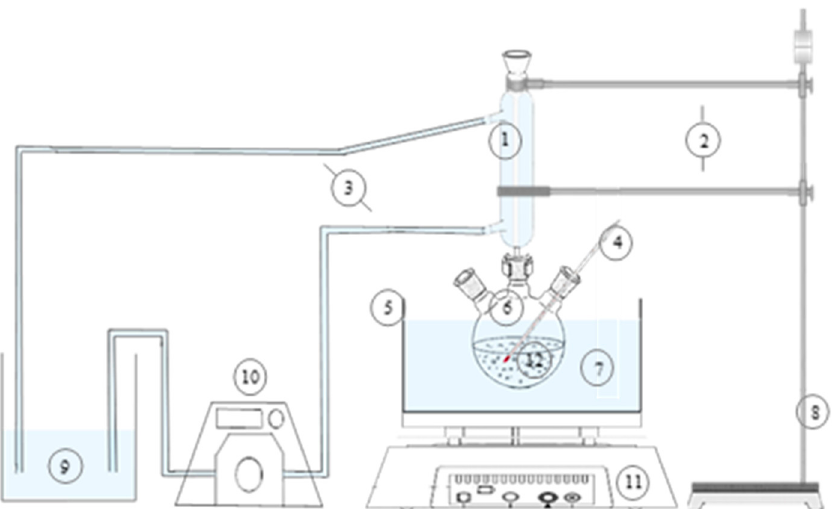
Figure 2. Schematic diagram of the reactor setup; ( 1 ) water condenser, ( 2 ) iron ring, ( 3 ) rubber tubing, ( 4 ) thermometer, ( 5 ) glass basin, ( 6 ) reactor vessel, ( 7 ) oil bath, ( 8 ) iron stand, ( 9 ) water source, ( 10 ) pump, ( 11 ) hotplate with magnetic stirrer, and ( 12 ) mixture (solvent and sample).